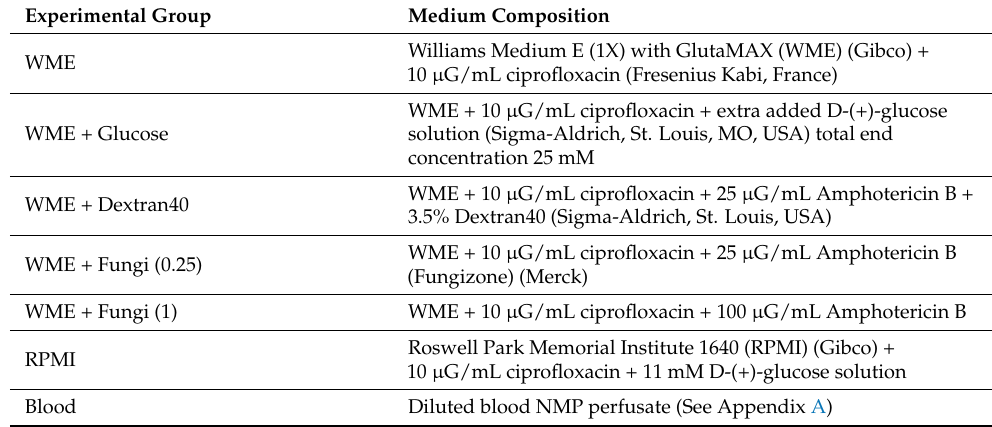
Table 1. Incubation